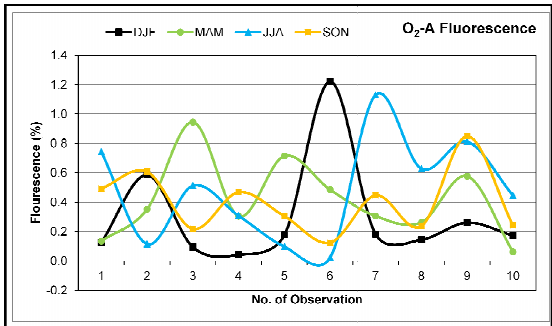
Figure 3 : Chlorophyll fluorescence intensity for different seasons obtained from O2-A bands of